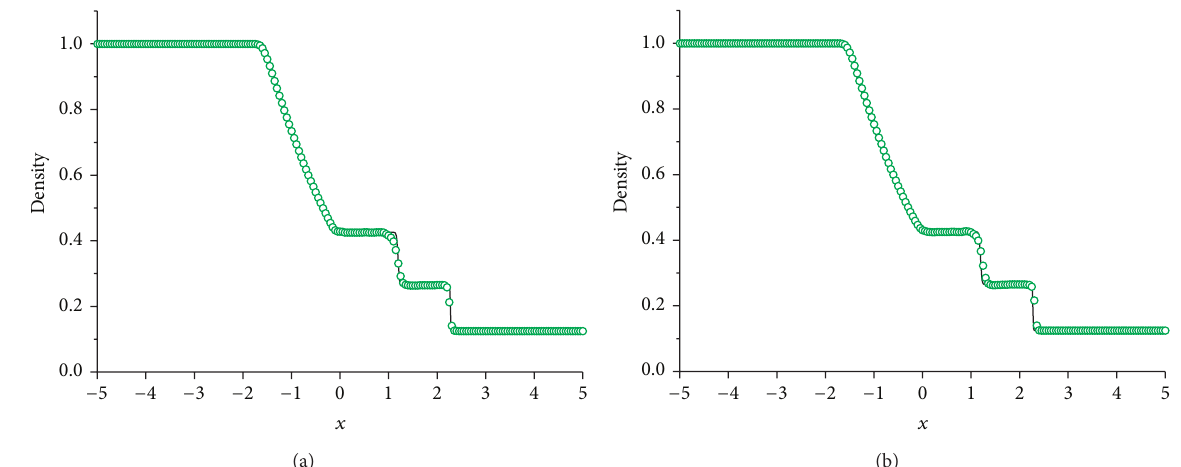
Figure 3: The numerical results of the Sod problem at 𝑡 = 1.3 with CFL = 9.9 , 𝑁 = 200 ; (a) M-SL-FV WENO 5 scheme; (b) M-C-SL-FD WENO 5 scheme; solid line: exact solution; circle: computed solution.